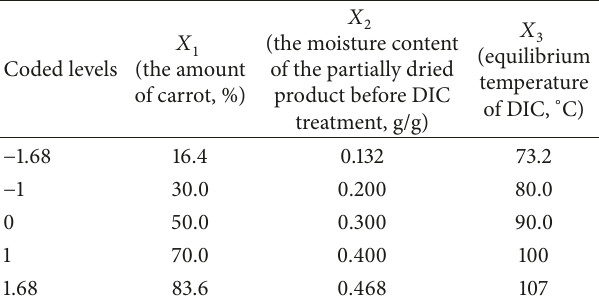
Table 1: The factors and levels of central composite design of response surface